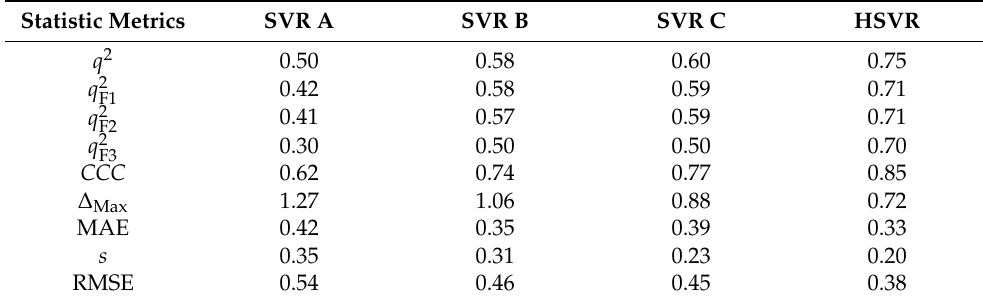
Table 3. Statistic metrics including q 2 , q 2 A, SVR B, SVR C, and HSVE in the test